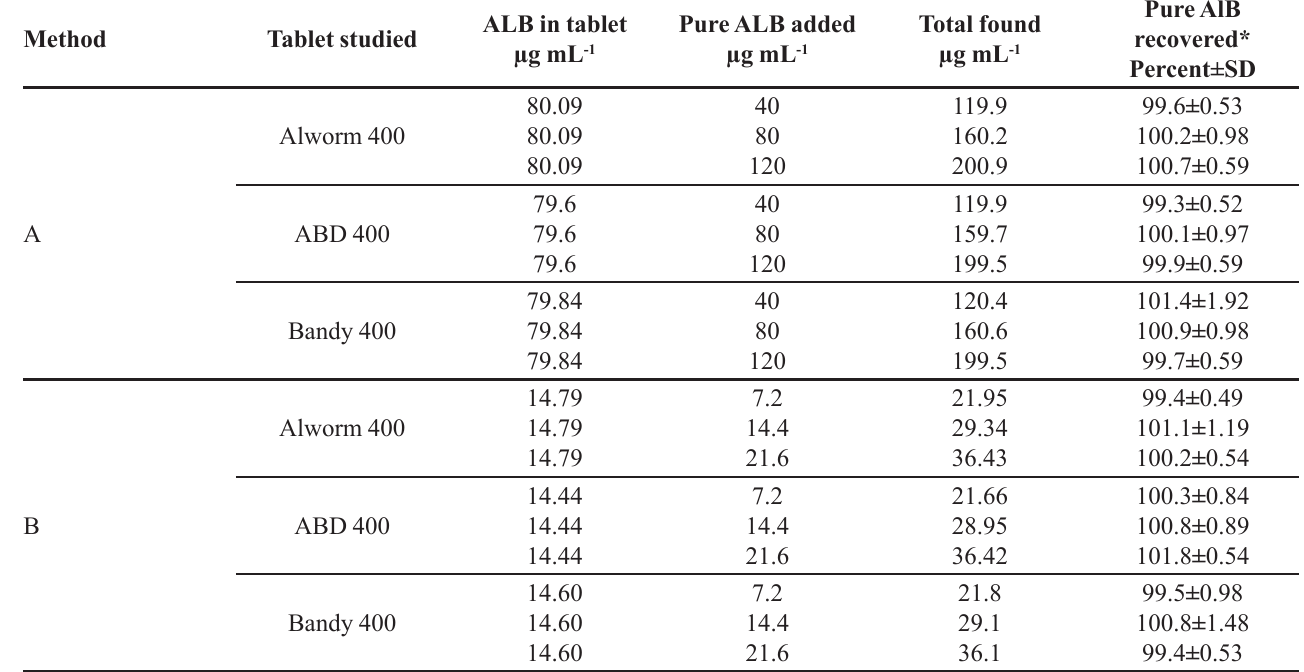
TABLE IV - Results of recovery study via standard addition method with tablet